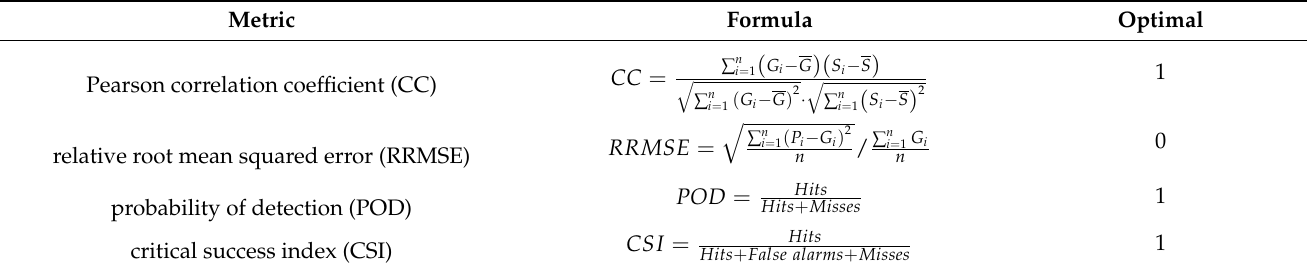
Table 1. Evaluation metrics used in this study. P and G mean products and rain gauge observation, respectively. Hits, Misses and False alarms in the table refer to the observed precipitation correctly detected by products, observed precipitation missed by products and the precipitation detected by the products but not observed by the rain gauge,